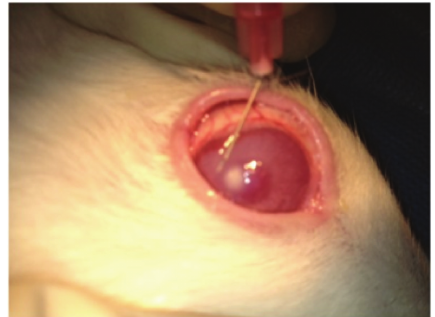
Figure 1: Intrastromal injection of voriconazole 50 microgram/ 0.1 mL in the operating